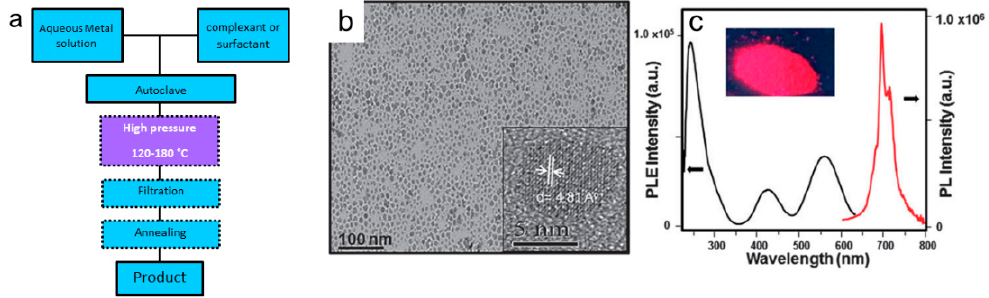
Figure 13. ( a ) Schematic flowchart of HS. ( b ) TEM image of ZnGa 2 O 4 :Cr 3 + dispersed in hexane prepared via HS. ( c ) Excitation (black curve, left) and emission (red curve, right) spectra of the ZnGa 2 O 4 :Cr 3 + dispersed in hexane. The inset shows the photograph of the PeL emission of the NP under 254 nm excitation (P = 6 W). λ em = 696 nm, λ exc = 254 nm. Reproduced from [230] with permission from The Royal Society of Chemistry. Table 4. Examples of PeL compounds, average size, synthesis method, emission wavelength ( λ exc ), and afterglow duration.